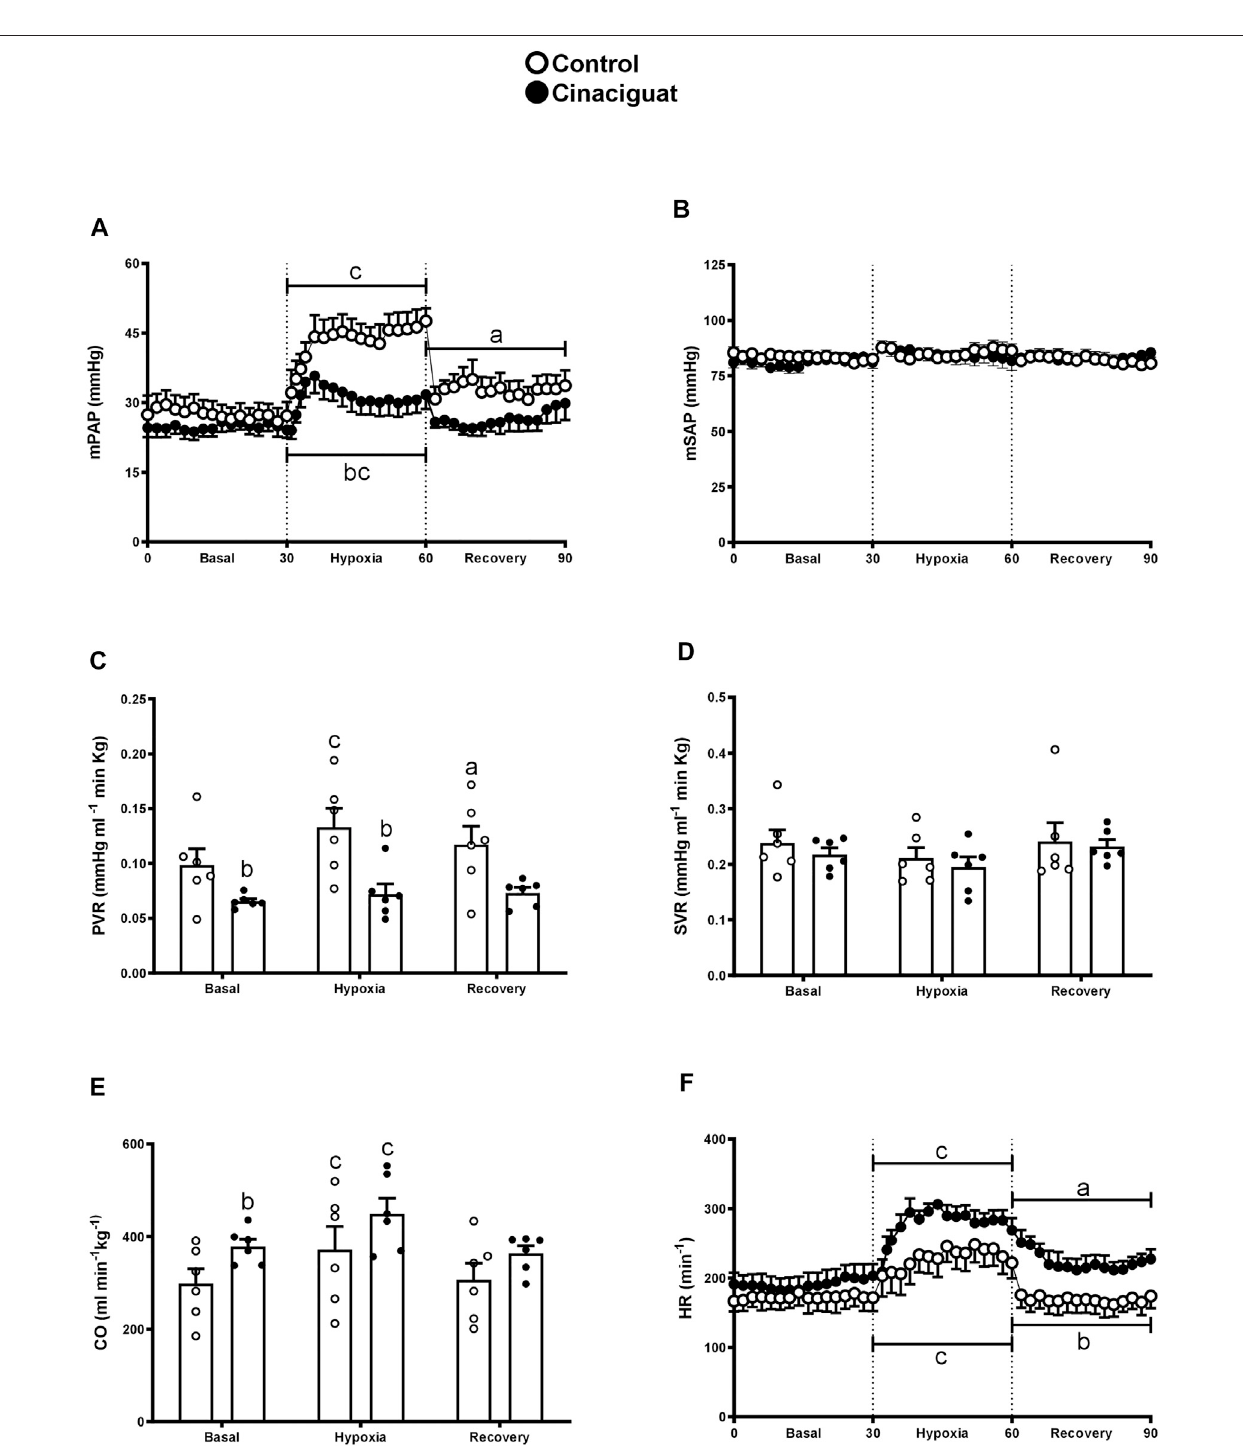
FIGURE 3 | Effect of Cinaciguat treatment on cardiopulmonary and systemic circulation following a superimposed episode of acute hypoxia in chronically hypoxic andpulmonaryhypertensiveneonatallambs.Meanpulmonaryarterialpressure[mPAP, (A) ],meansystemicarterialpressure[mSAP, (B) ],pulmonaryvascularresistance [PVR, (C) ], systemic vascular resistance [SVR, (D) ], cardiac output [CO, (E) ], and heart rate [HR, (F) ]. Control (Open circles, n = 6) and Cinaciguat-treated lambs (Black circles, n = 6). Values are means ± SEM. Signi fi cant differences ( p ≤ 0.05): a vs. basal period, b vs. Control group; c, hypoxia vs. basal and recovery periods.